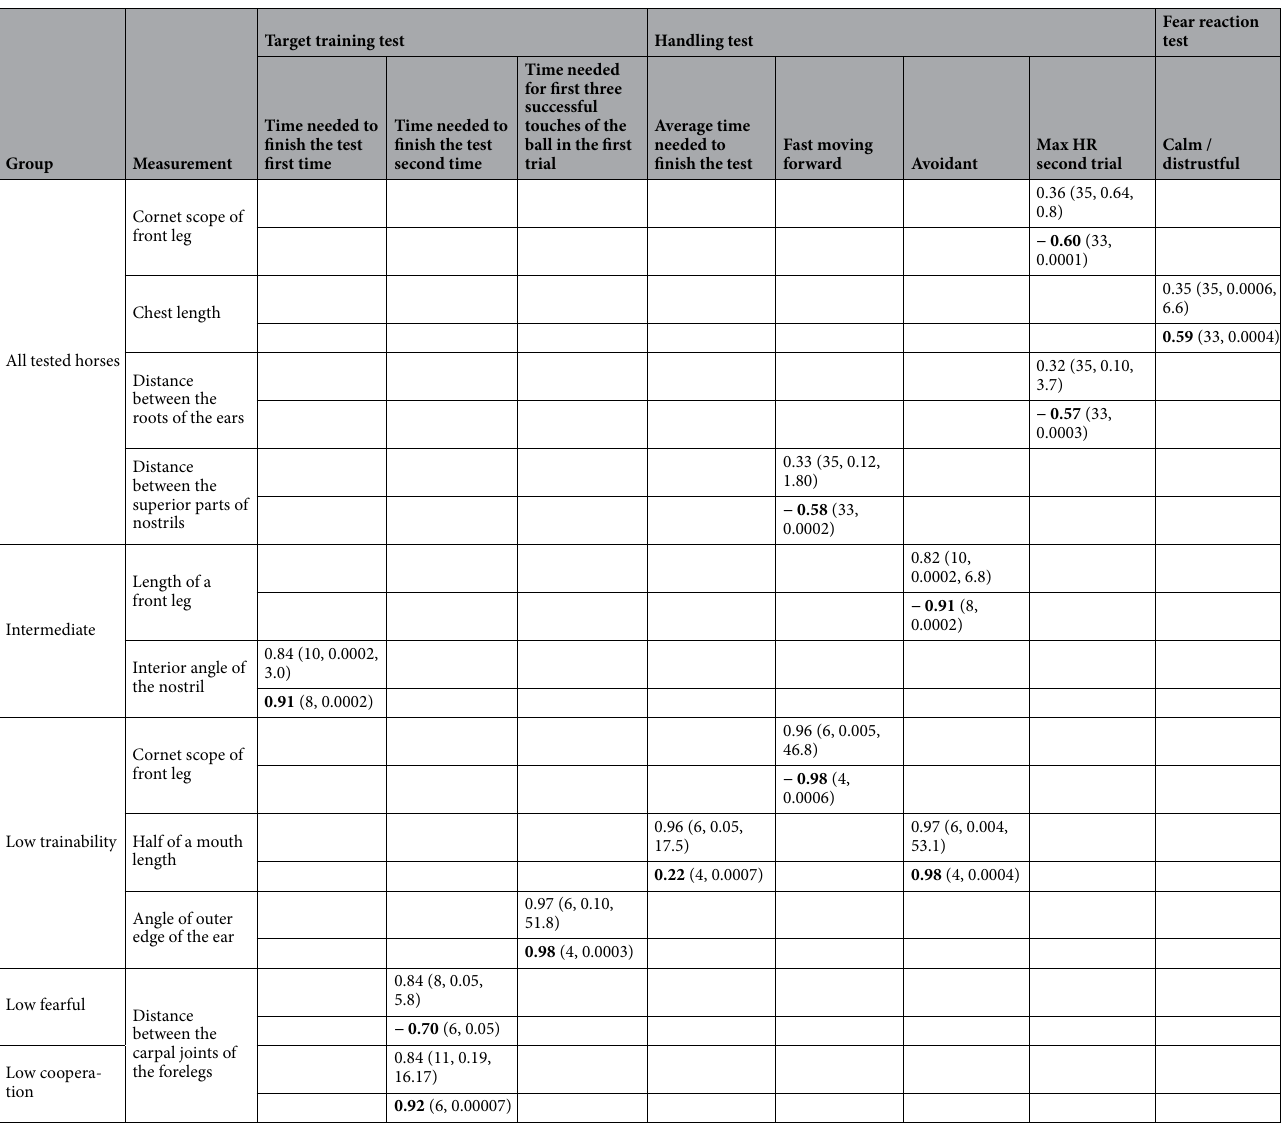
Table 1. Anatomical measurements with only significant coefficient of determination for predicting behaviours, with top number presenting the coefficient of determination (degrees of freedom, P-value, F-value) and the bold font number presenting the Pearson correlation coefficient (degrees of freedom,